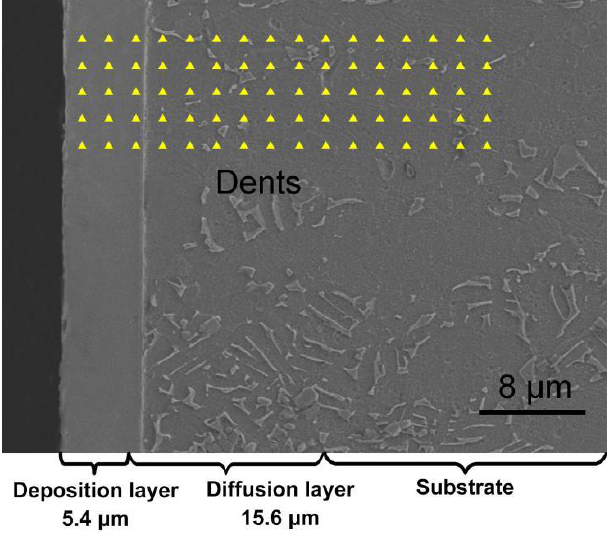
Figure 6. Cross-sectional SEM micrograph of the Mo surface-modified TC4.